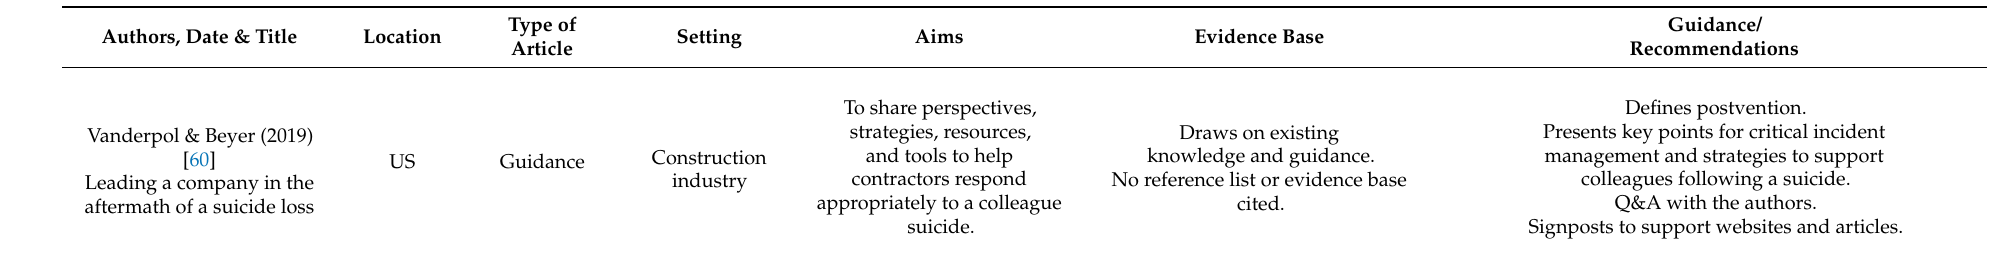
Table 4. Attributes of included